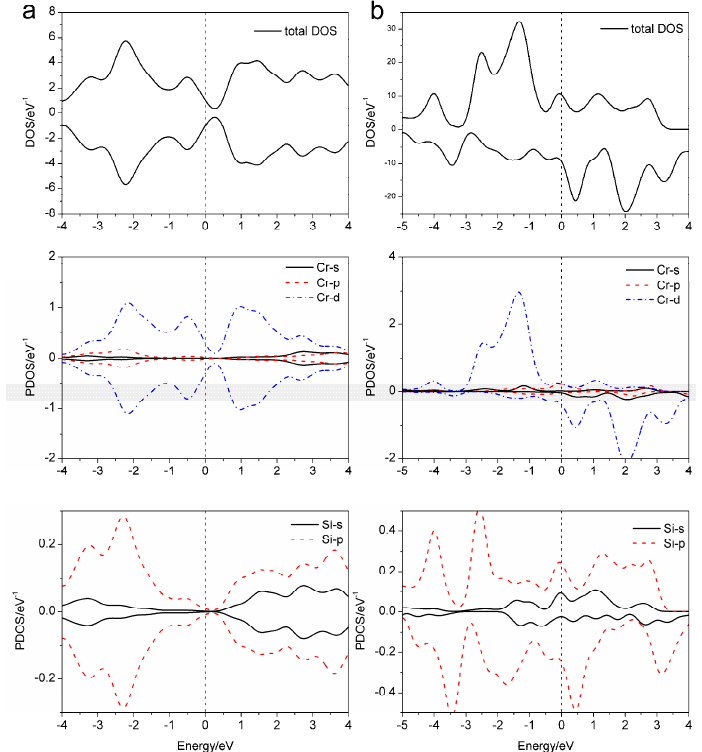
Figure 4. Total and partial density of states (DOS) varies from the energy for ( a ) bulk and ( b ) monolayer CrSi 2 .